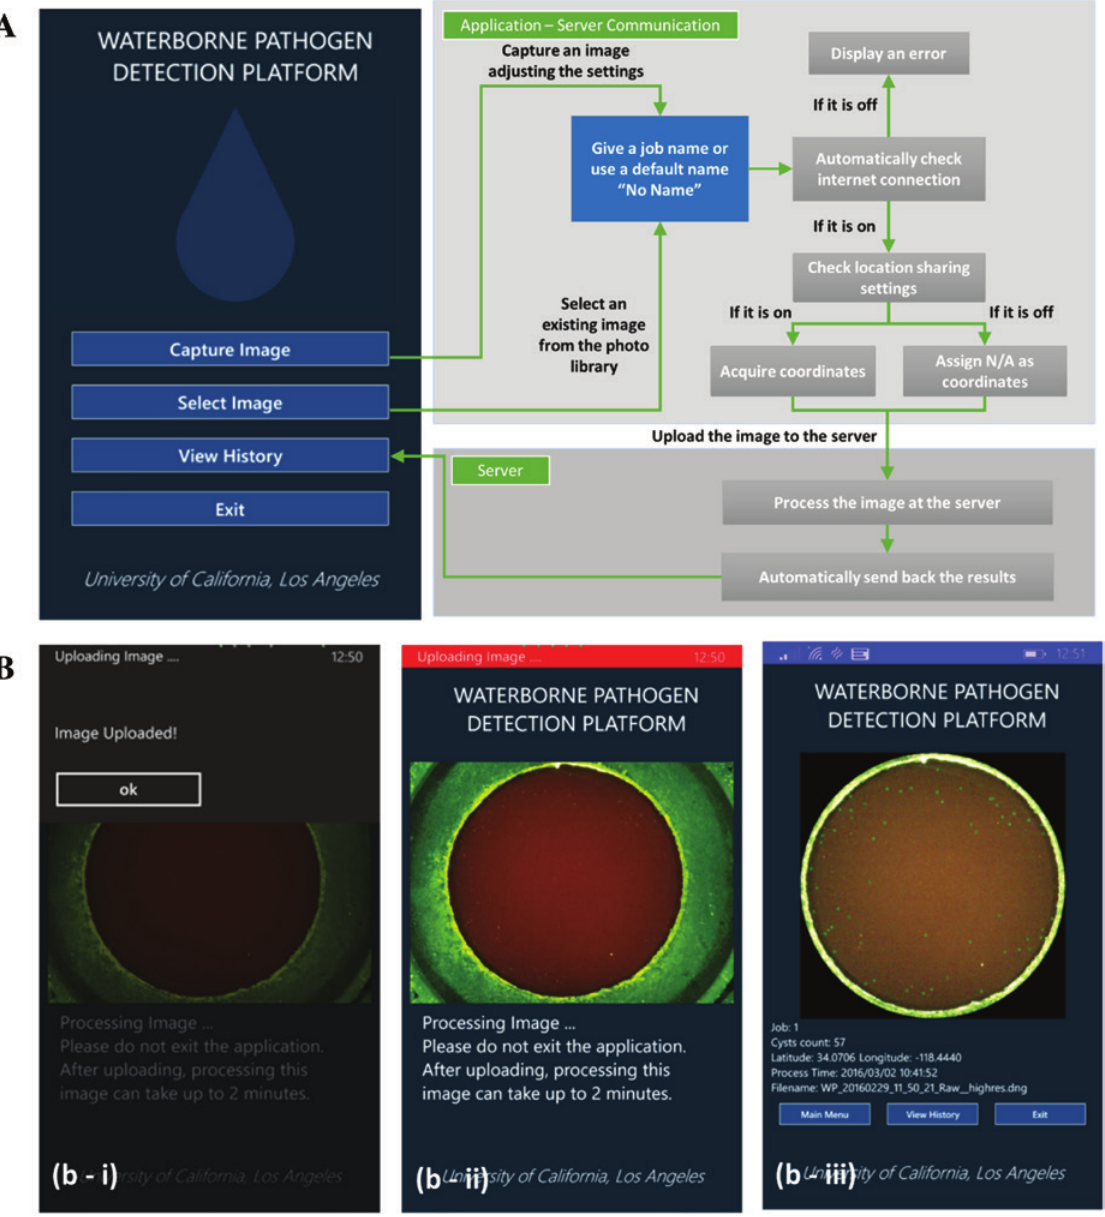
Figure 3: (A) Following our previous design reported in [11], graphical user interface of our smartphone application, GiardiaAnalyzer , is shown. The new version of the application has several additional features: (1) it enables parallel processing of the acquired images in the server, saving processing time; (2) it provides continuous feedback to the user about the status of the image analysis; and (3) it enables assigning a job name for each image to be uploaded to server. (B) Screenshots of the application for different stages of the image analysis. (B-i,ii,iii) Photographs demonstrating the feedback to the user about the image analysis and processing of the